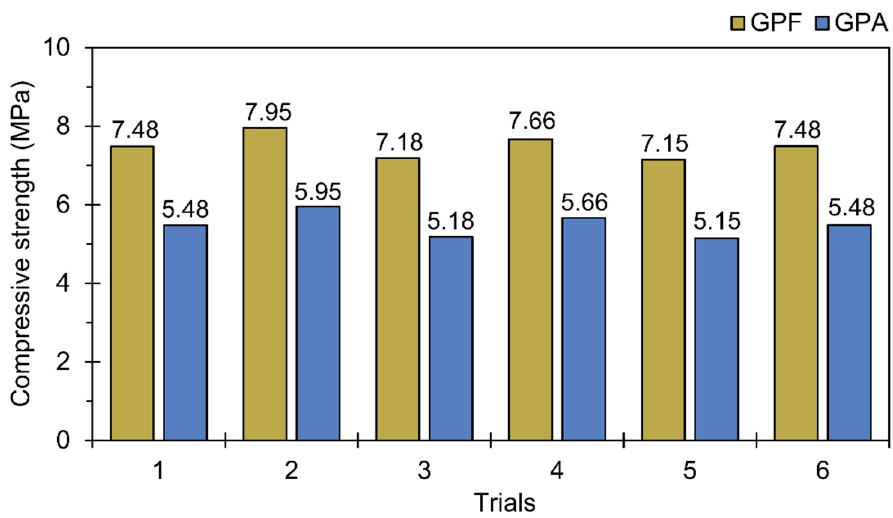
Figure 9. Unconfined compressive strengths (UCS) of geopolymer composites without POFA (GPA) and with POFA (GPF).